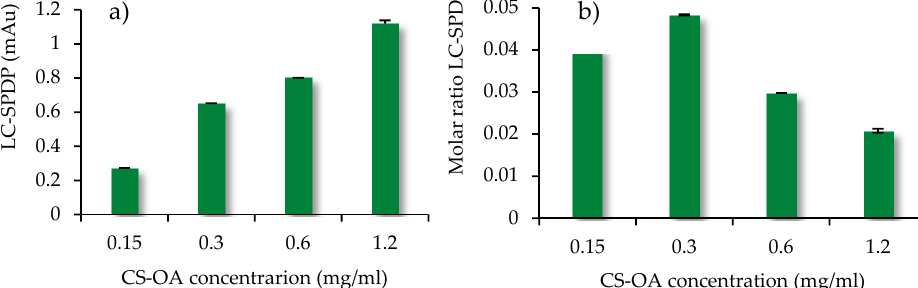
Figure 4. ( a ) pyridine-2-thione absorbance (mAu) at 343 nm released after DTT reaction; ( b ) molar ratio LC-SPDP to chitosan concentration (mean values ± s.d., n = 3).